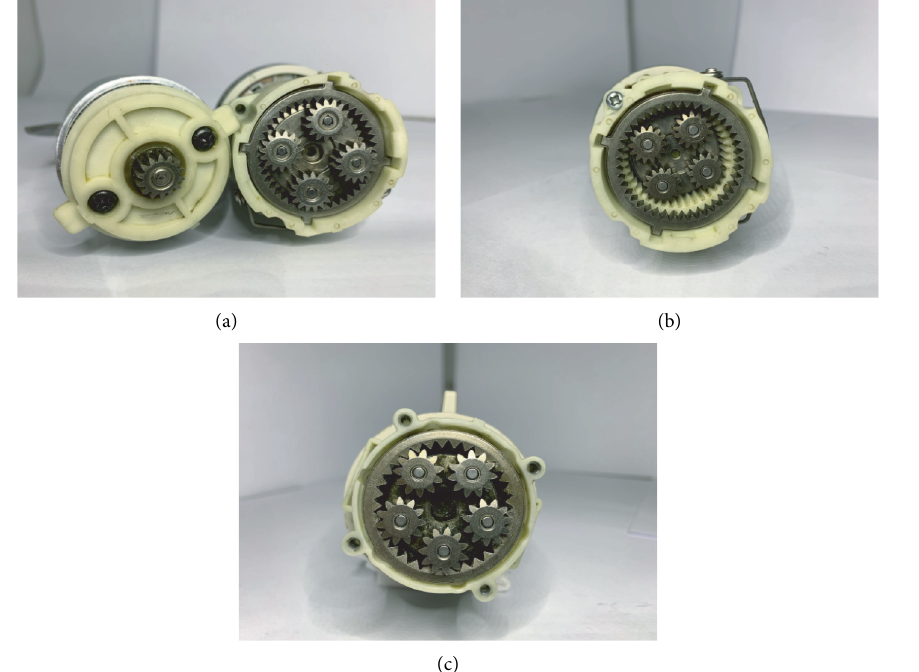
Figure 2: (a) Healthy EID with a working sun gear connecting the motor and gearbox. (b) Healthy EID with a working ring gear. (c) Healthy EID with a working planet gear.